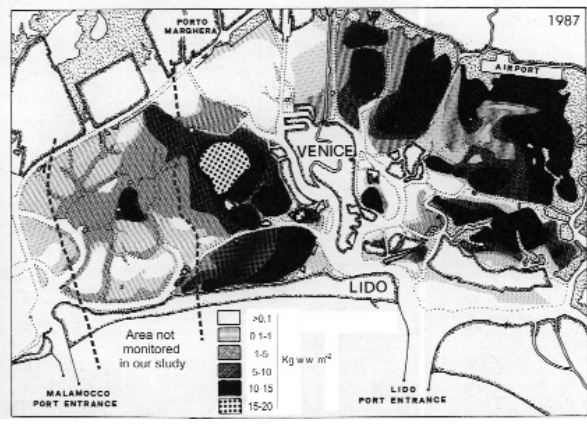
F IG . 3. – Macroalgal distribution in central Lagoon of Venice in June 1987 (from Sfriso et al ., 1992a, modified).